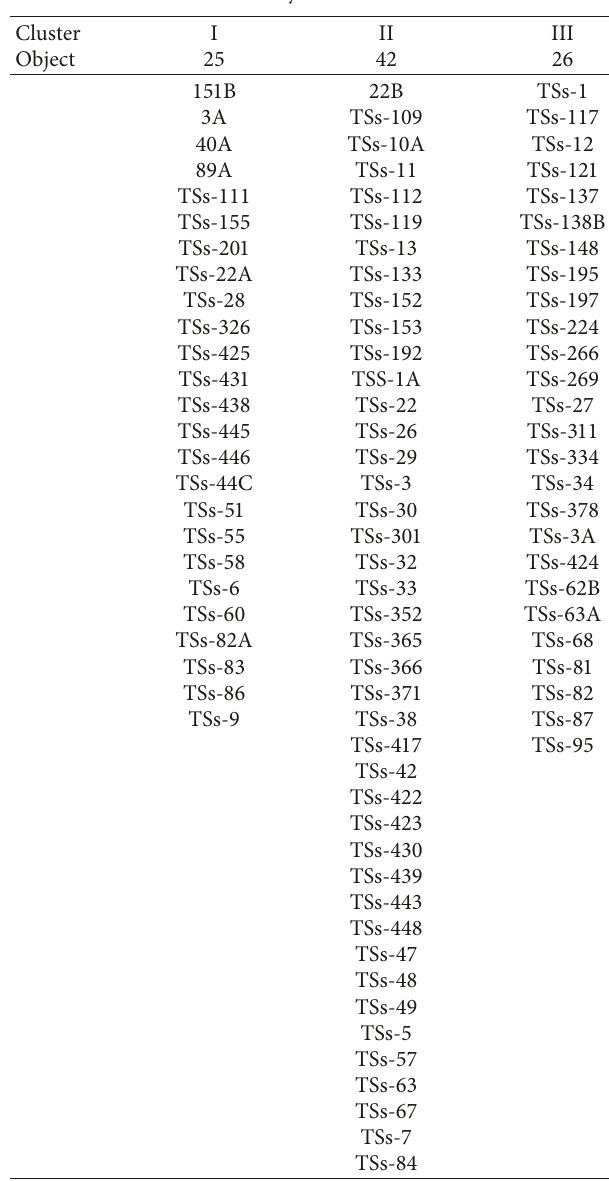
Table 2: Cluster analysis of 93 AYB accessions.